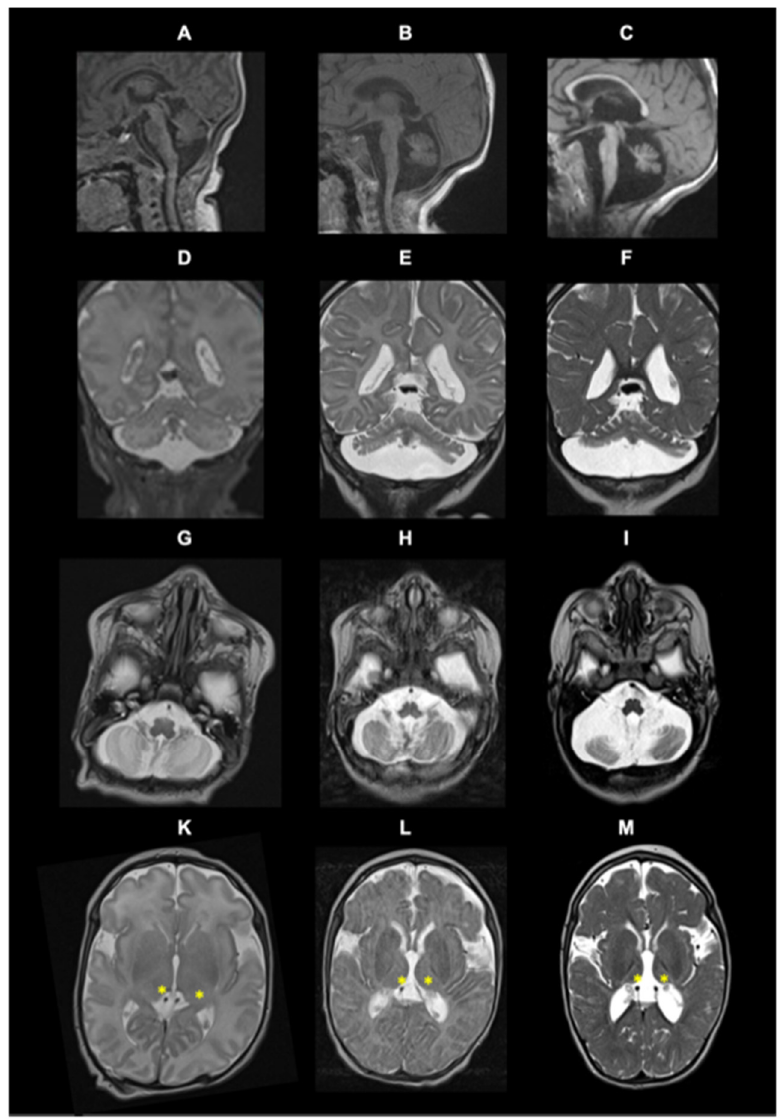
Figure 1. Brain MRI of the index case at the age of 2 weeks ( A , D , G , K ), 3 months ( B , E , H , L ), and 20 months ( C , F , I , M ). Description from first to last raw: sagittal T1 ( A , B , C ); coronal T2 ( D , E , F ); and axial T2 ( G , K , H , L , I , M ).